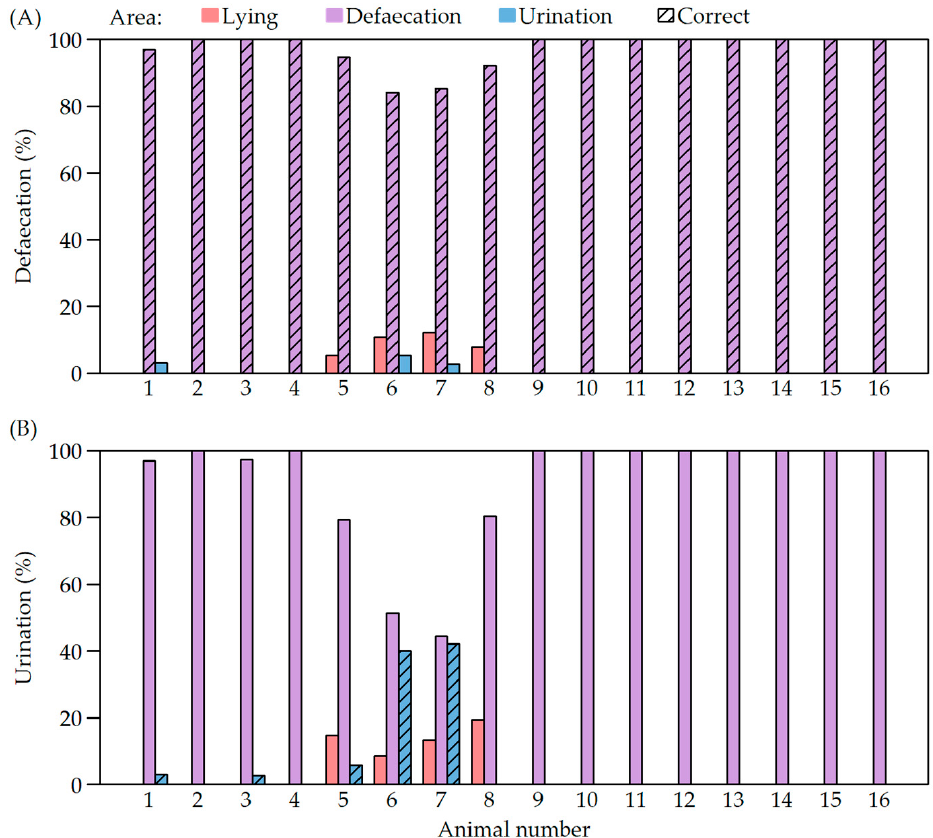
Figure 4. ( A ) Percentages of defaecations and urinations of individual animals during video observation; ( B ) percentages of urinations of individual animals in the different functional areas (lying area, defaecation area and urination area of the toilet) during video observation.